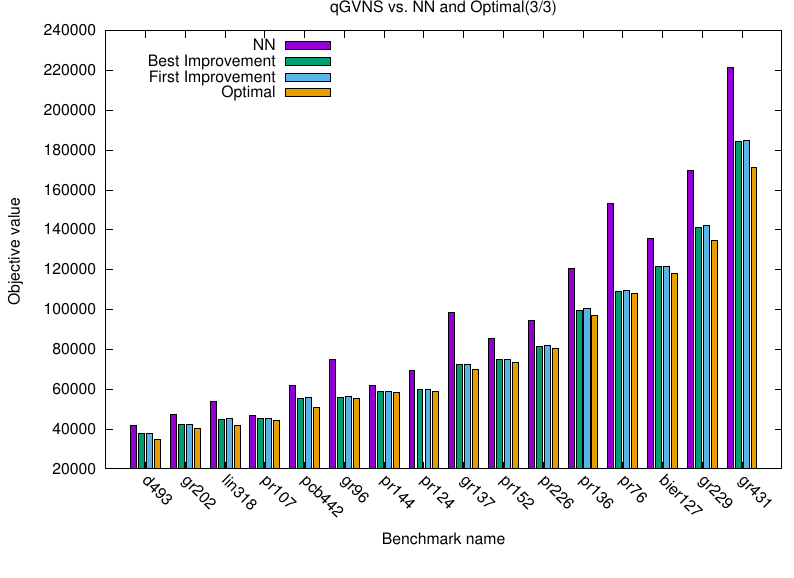
Figure 3. NN vs. GVNS vs. OV